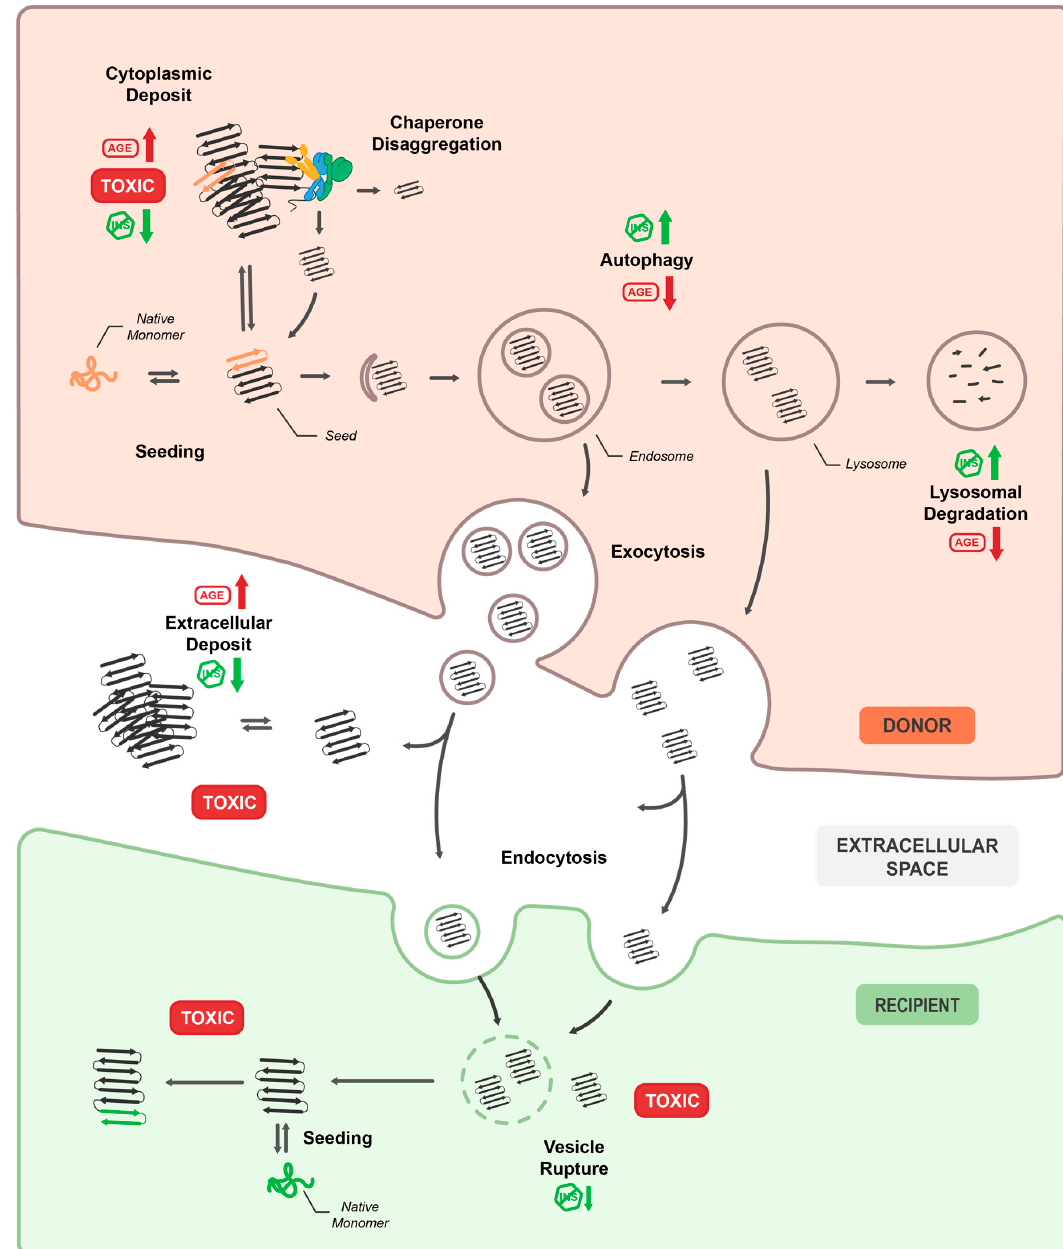
Figure 2. Schematic overview of the cellular pathways involved in the propagation of prion-like aggregates within and between C. elegans tissues. In the donor tissue, native monomers may spontaneously or due to cellular stress acquire a pathological β -sheet rich conformation, which in turn can seed the misfolding of cognate monomers and thus grow into larger fibrils that eventually deposit into large cytoplasmic inclusions. While the exact nature of the toxic protein species is still unclear, the process of aggregate formation has been clearly linked to cell autonomous toxicity. The cellular chaperone network attempts to dissociate protein aggregates, resulting in the generation of additional seeds that may promote prion-like propagation. Misfolded and aggregated protein species are recognized by the autophagy machinery and subsequently either targeted for lysosomal degradation or removal via exocytosis. Aggregated material expelled from the donor tissue can end up in extracellular deposits that can damage adjacent tissues non-cell autonomously, or it can be